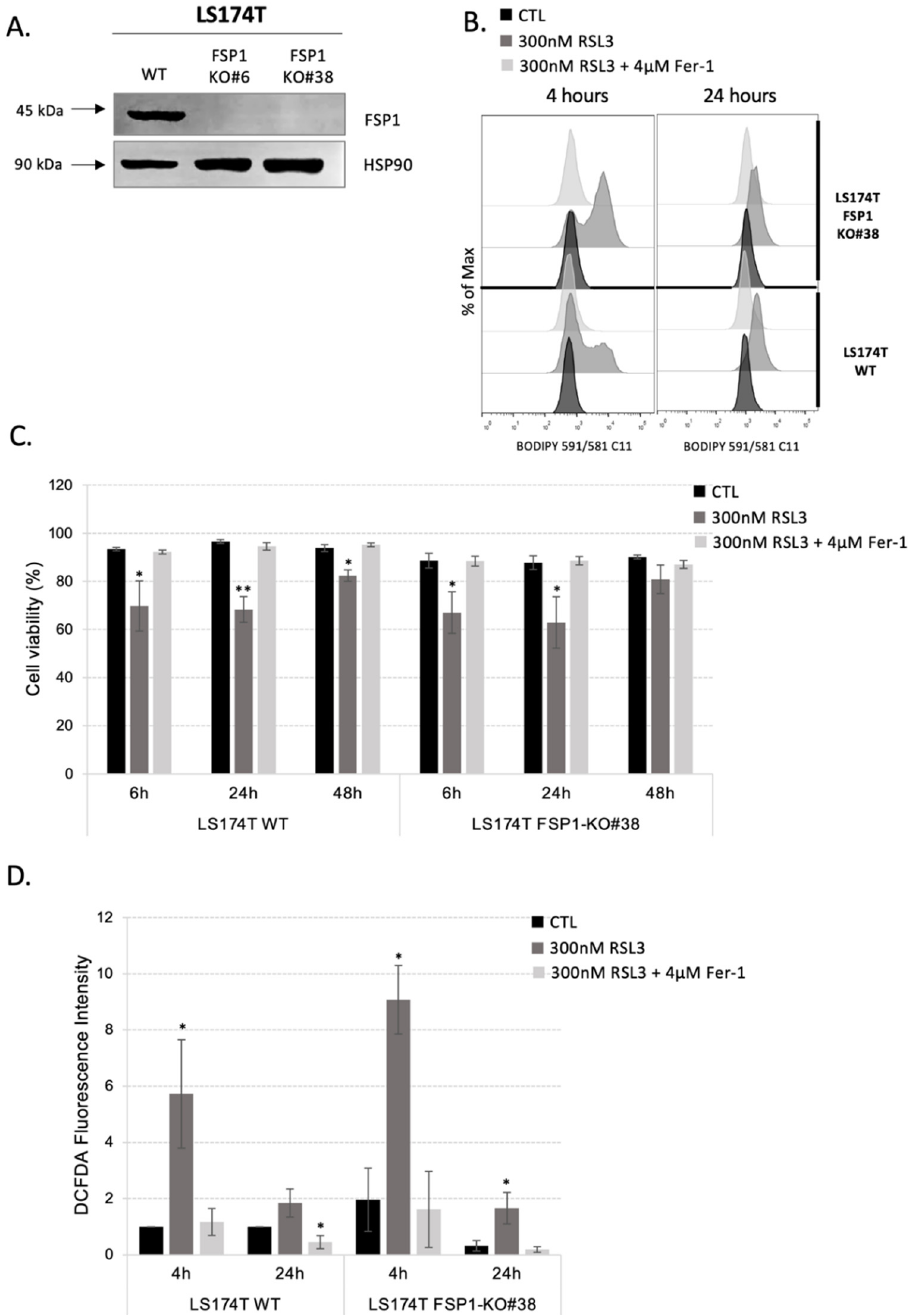
Figure 2. Pharmacological inhibition of GPX4 in the LS174T cells with FSP1-KO background is not suffi- cient to induce ferroptosis. ( A ) The expression of FSP1 was analyzed in LS174T WT and two independent FSP1-KO (#6 and #38) clones. Three independent experiments were performed, and representative blots are shown. ( B ) Lipid hydroperoxide content was measured in LS174T WT and FSP1-KO#38 cells 4 h and 24 h upon seeding in media supplemented or not with 300 nM RSL3 and 4 µ M Fer-1. Presented histograms are representative of three independent experiments. ( C ) LS174T WT and FSP1-KO#38 cells were seeded in media supplemented or not with 300 nM, in the presence or not of 4 µ M Fer-1. Cell viability was analyzed after 6 h, 24 h and 48 h. The results are presented as mean ± SEM, n = 3. * p < 0.05, ** p < 0.01, comparison with corresponding cell line in control conditions. ( D ) Intracellular ROS level was measured by DCFDA staining (see Section 2) in LS174T WT and FSP1-KO#38 4 h and 24 h after seeding in media supplemented or not with 300 nM RSL3 and 4 µ M Fer-1. Intracellular ROS levels are presented in fold change (mean ± SEM, n = 3). * p < 0.05, comparison with corresponding cell line in control